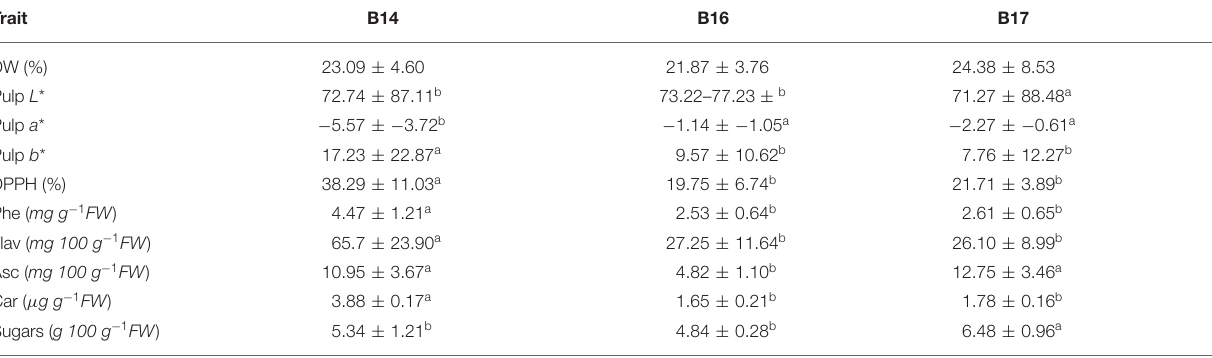
TABLE 6 | Fruit quality traits in three local eggplant landraces cultivated in Spain. Trait